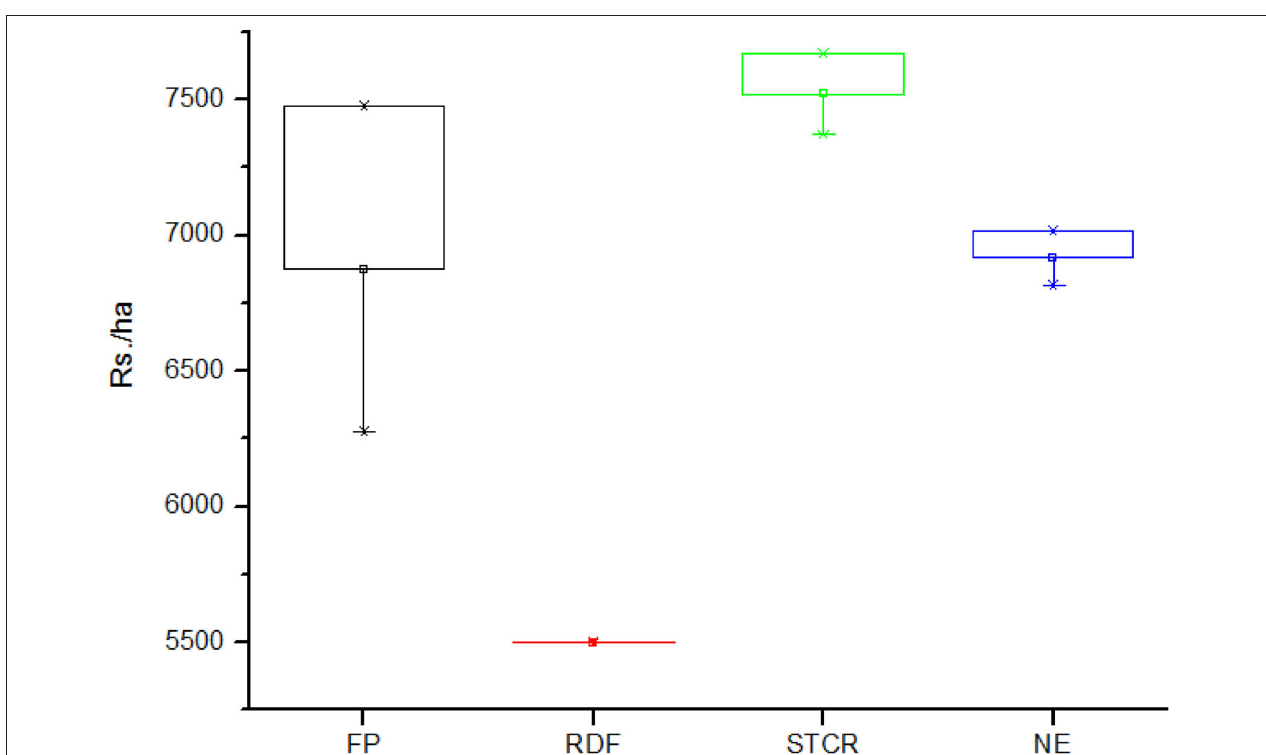
FIGURE 4 | Investment cost on fertilizers for the different nutrient management practices.